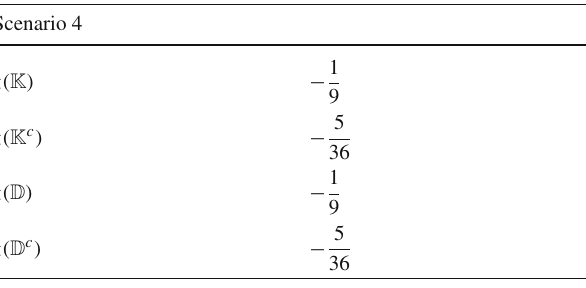
Table11 Valuesofthe U ( 1 ) (cid:2) chargesfortheexoticquarksinU μν SSM models using solution (30) with the hypercharges shown in Case 1 of Table 10. The U ( 1 ) (cid:2) charges of the rest of the fields are given in Table 2 and Scenario 4 of Table 9. The minimal number of singlets under the SM gauge group consistent with these charges is n ν c = 2